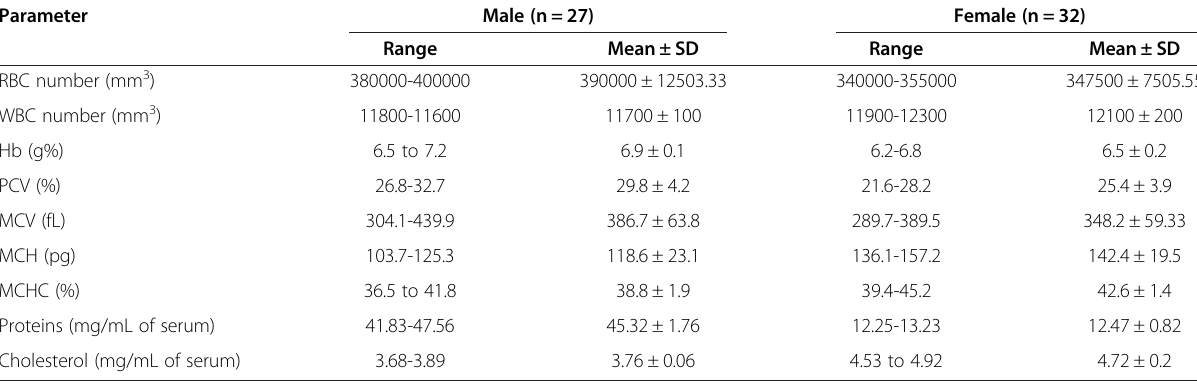
Table 3 The numbers of RBC and WBC, Hb contents, PCV, MCV, MCH, MCHC, amount of protein and cholesterol in the blood in male (n = 27) and female (n = 32) snakes of Naja naja (p < 0.05)